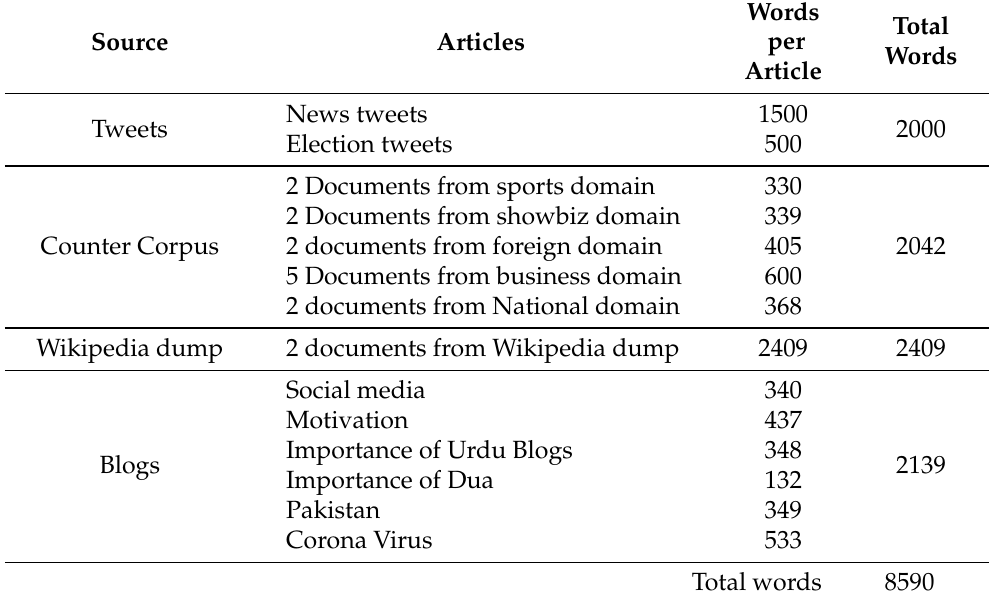
Table 4. Source details of the test dataset.